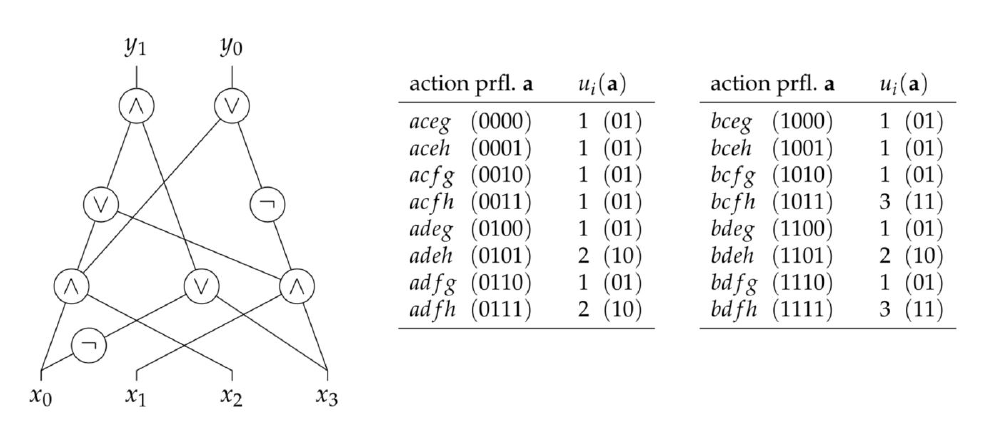
Figure 5. The Boolean circuit on the left represents the utility function u i on the right for a player i over the action profiles of the game in Example 1. The binary representations of action profiles and numerical values are depicted in